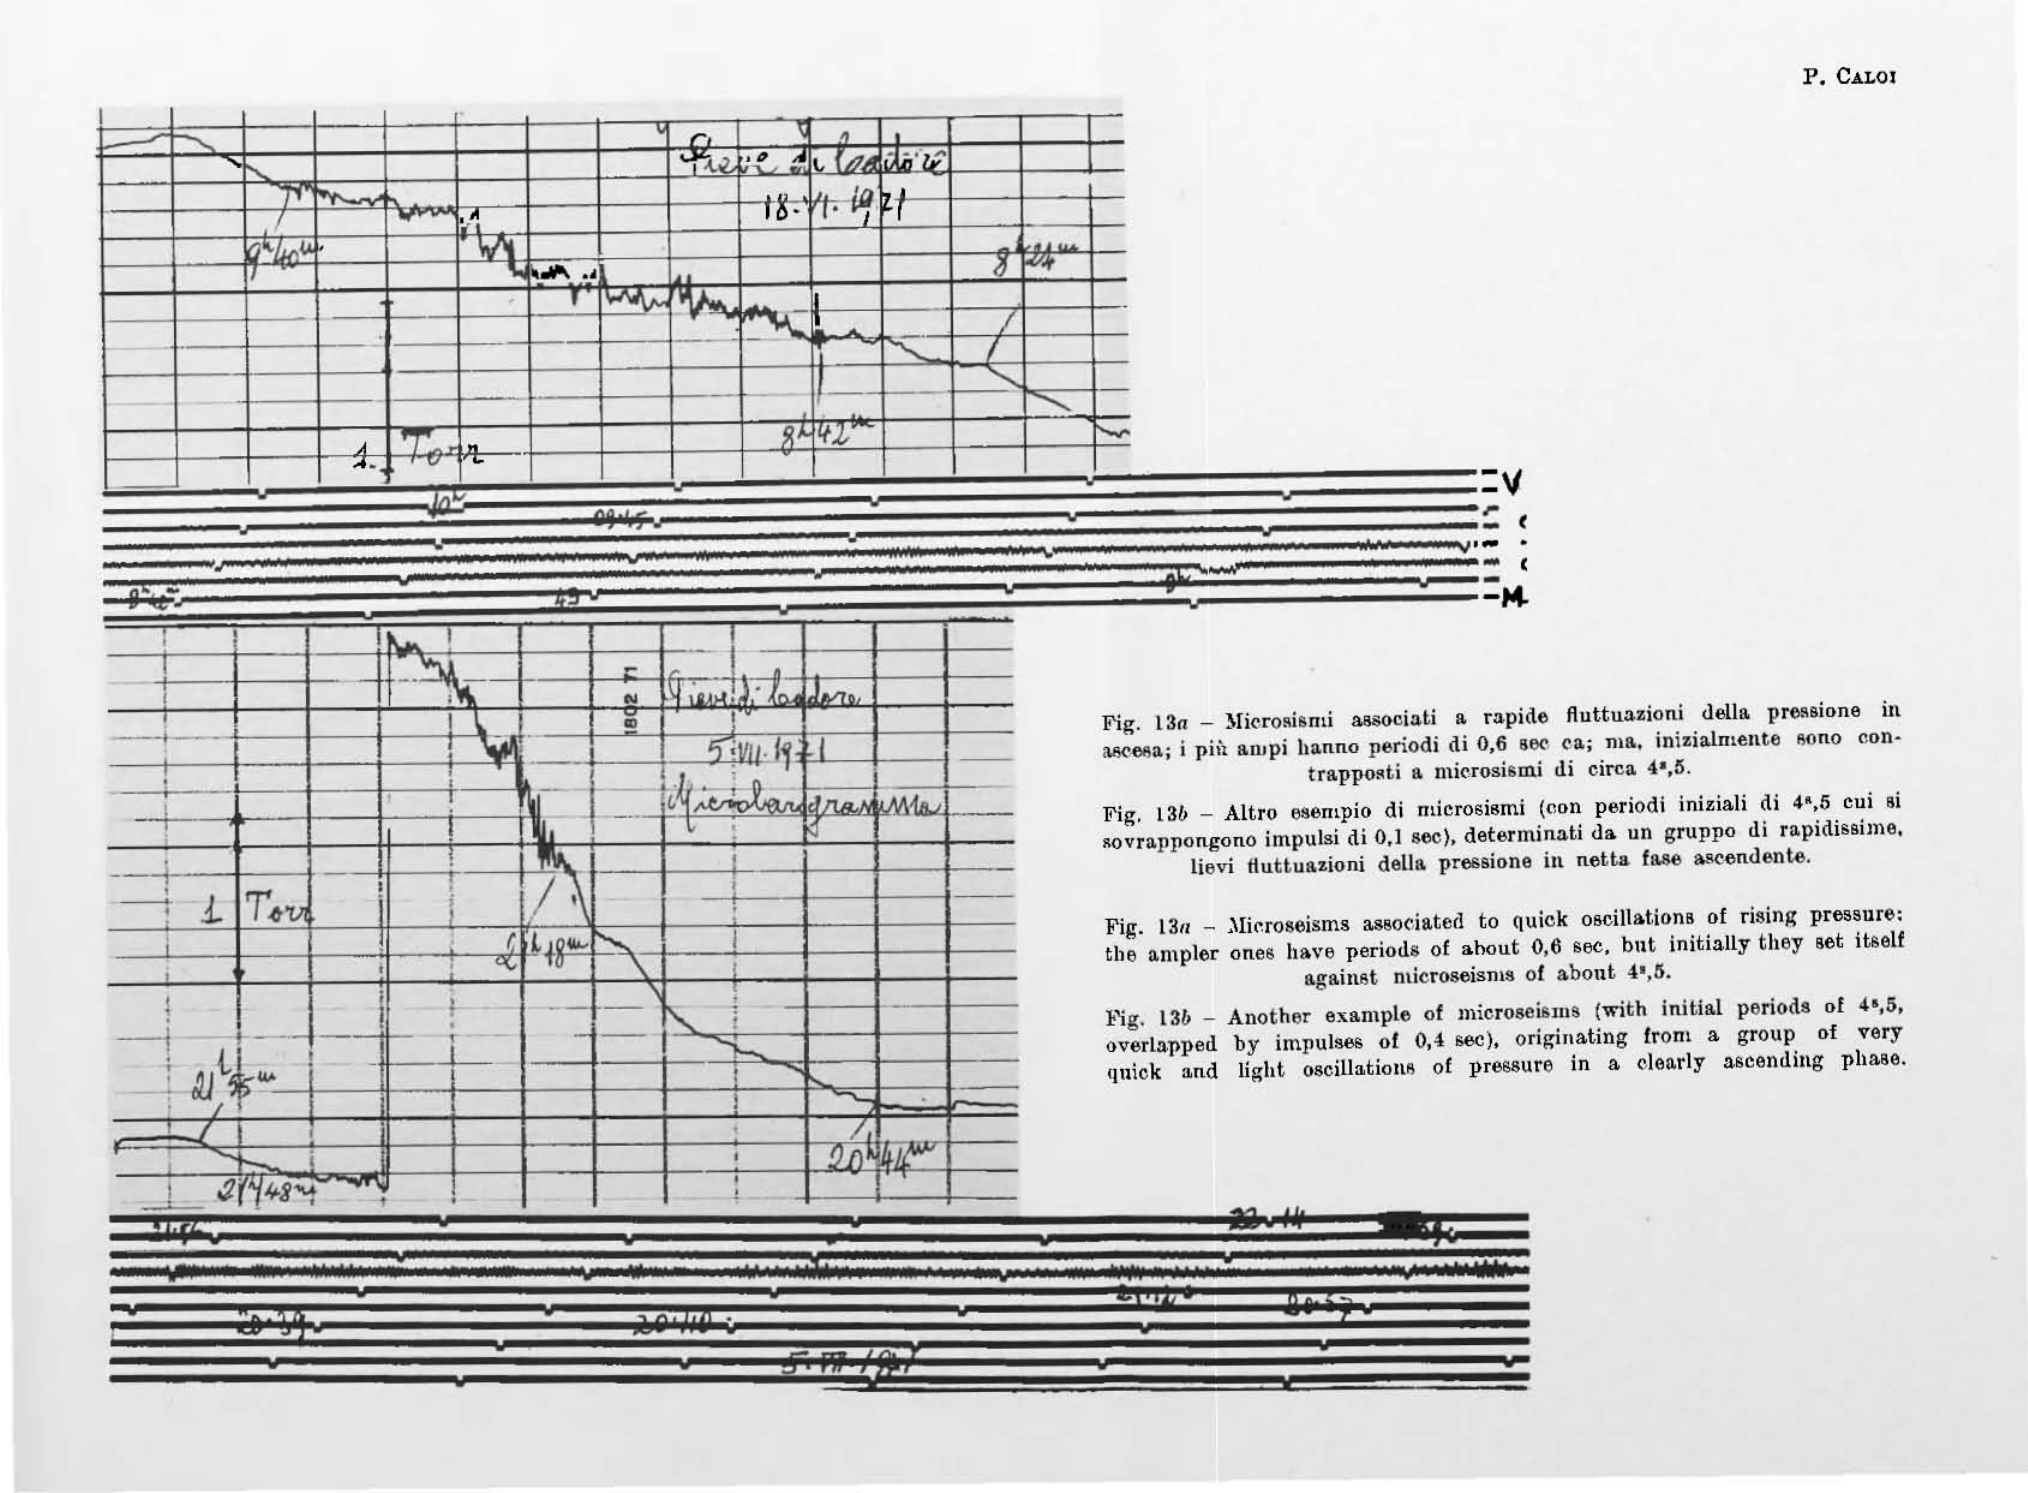
, e fluttuazioni della pressione in rapid Fig. 13a ~Ikro!\i5mi associati 6(' ca; ma, inizialmente 6Ono con· ascesa.; i pili ampi hanno periodi di 0,6 Il i di circa. 4",!S. trll.ppo~ti 9. mierosism (con periodi iniziali di 4",5 cui si Fig. 13/1 Altro esempio di ndcrosi~mi inati da. un gruppo di rapidissime. ~ovrappongono impulsi di 0,1800), determ in netta. fa.se a.~cefltlente. lievi fluttuAzioni della pressione ick oscillations of rising pressure: Fig. 13/1 _ .'Ikroseisms as8ods.ted to qu 0,6 sec, but initially they set itself the ampler ones ha.ve perioù' ol ahout f abollt 4',6. a.gainflt micr08eisms o smll (with initial periods o( 4-,5, J<'ig. 13b _ Another example a f microsei gina.ting from a group of very avarlapped by impulses of 0,4. sec), ori a in a danr1y ascenùing phas6. qllick , nd light O8cillatiollS , f